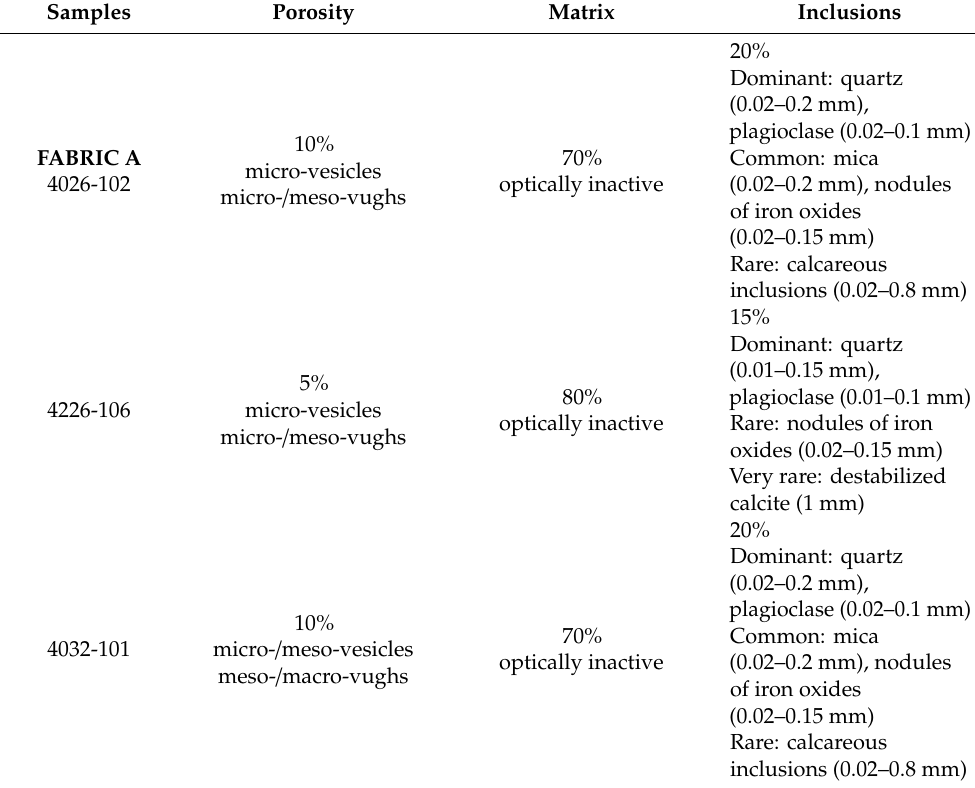
Table 2. Microscopic features and petrographic composition of the ceramic samples analyzed. Samples Porosity